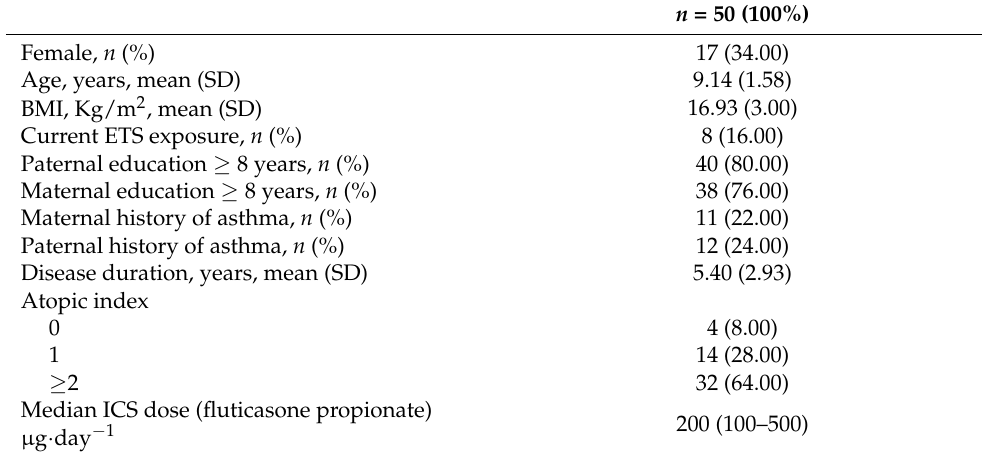
Table 1. Baseline characteristics of the study